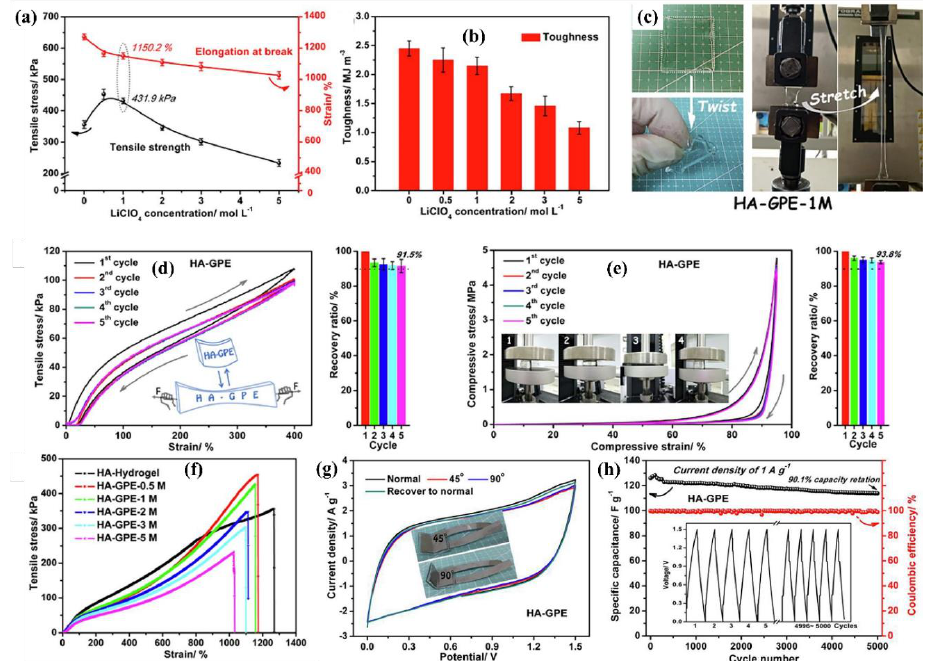
90°). ( h ) Cycling performance collected for the current density of 1 A g −1 (black: capacity retention; red: Coulombic efficiency as a function of cycle number) [192]